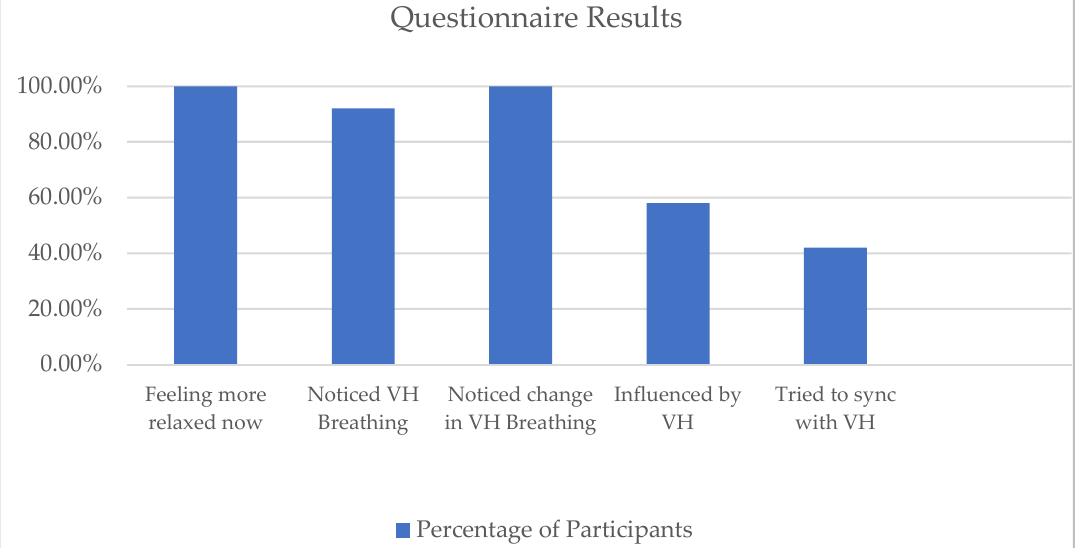
Figure 12. Post-experimentation questionnaire results.